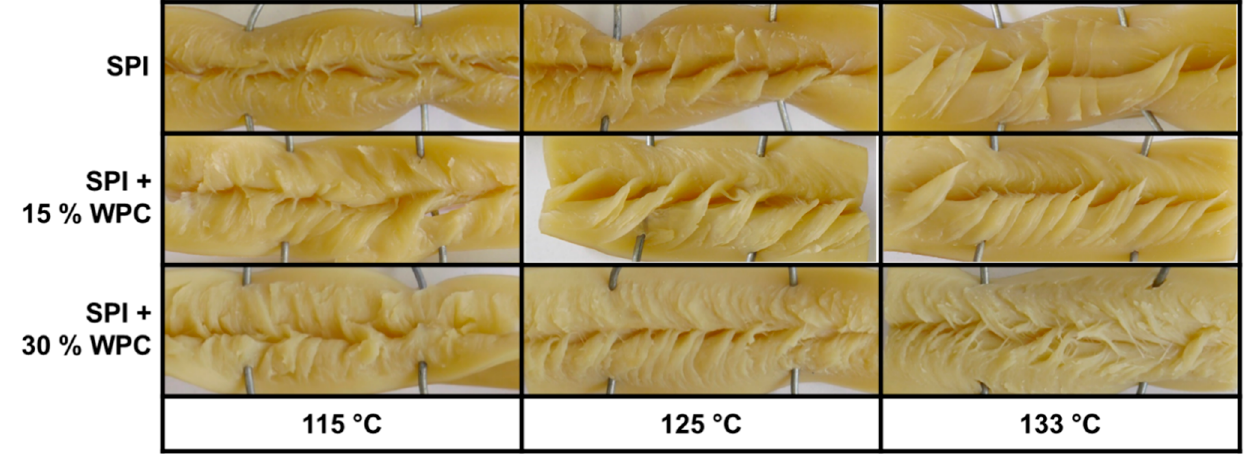
Figure 4. Product structure of extrudates for different protein blends (0–30% WPC) and material temperatures (115–133 °C).